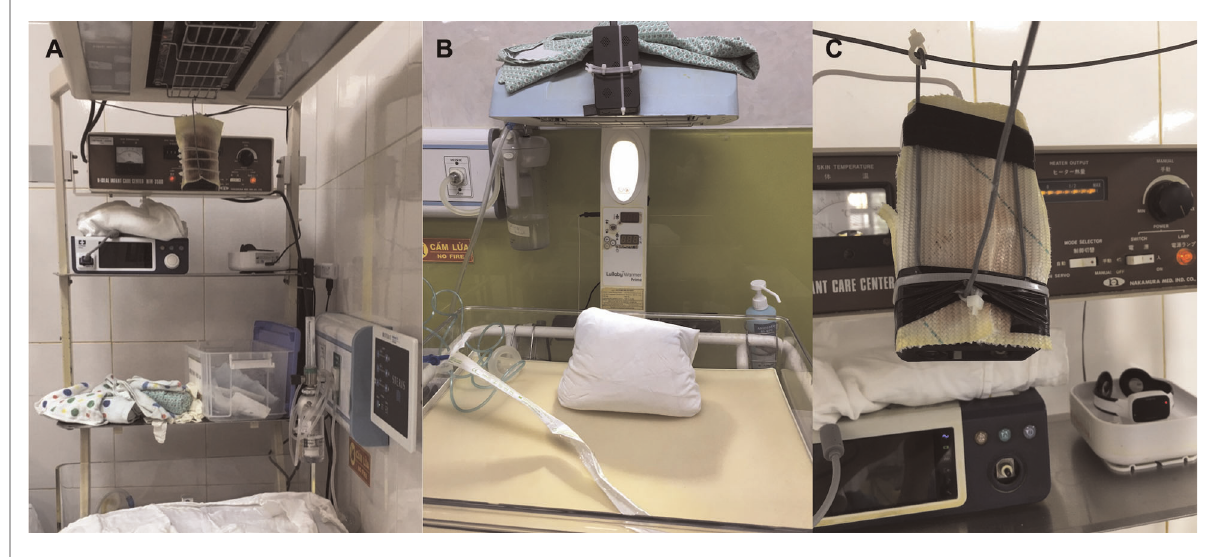
FIGURE 4 ( A ) The capture of setting up version 1. ( B ) The capture of setting up version 2. ( C ) Camera